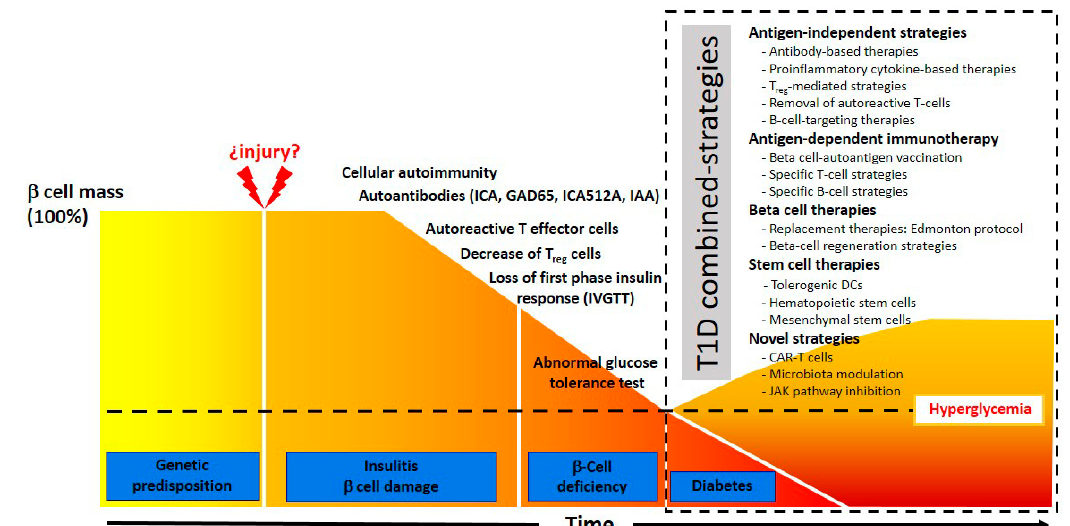
Figure 1. Progression of T1D and combined-strategies for T1D treatment.